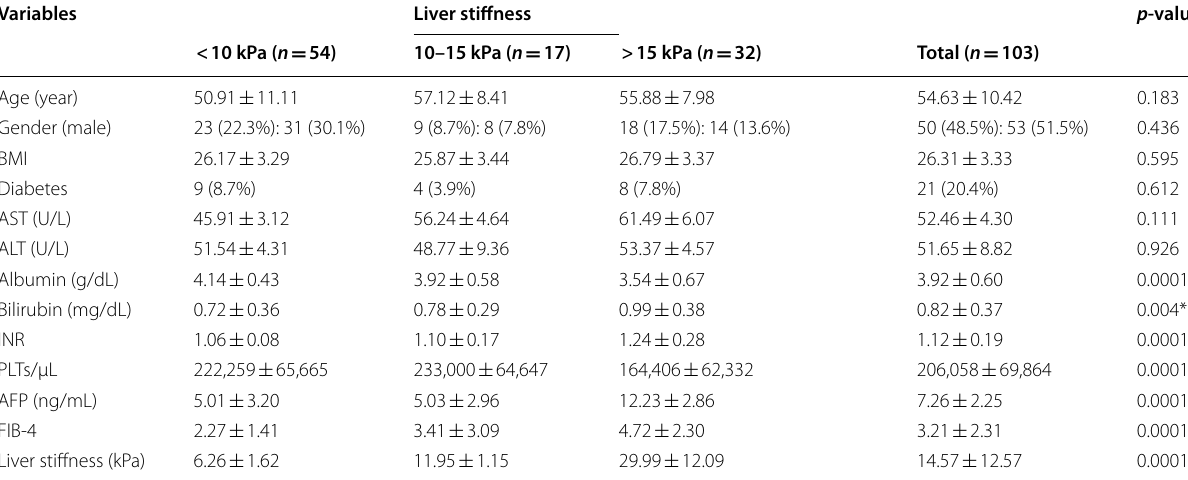
Numerical data are expressed as mean standard deviation, and categorical data are expressed as number (percentage) ± p -value: probability value. *Significant ( p < 0.05)